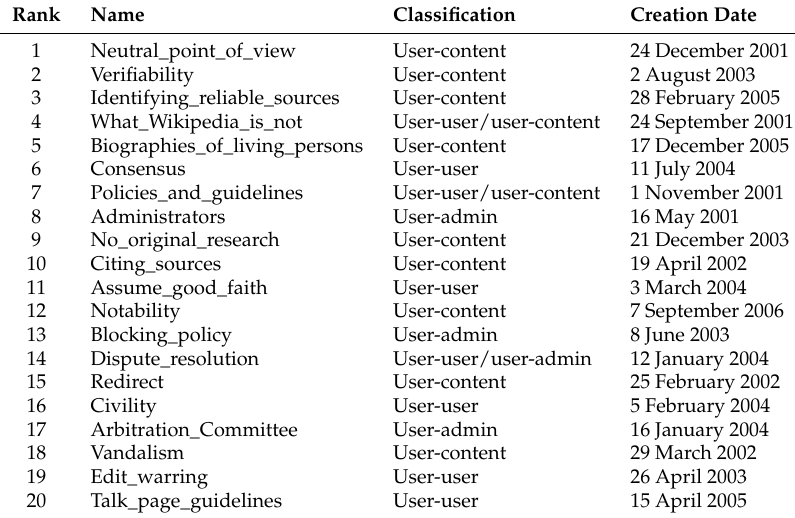
Table 1. Core norms. Top twenty pages, by eigenvector centrality, in 2015. All are either policy or guideline pages, and all were in place by the end of 2006. The majority of these core norms were created before 2004, when the population was less than 3% of its